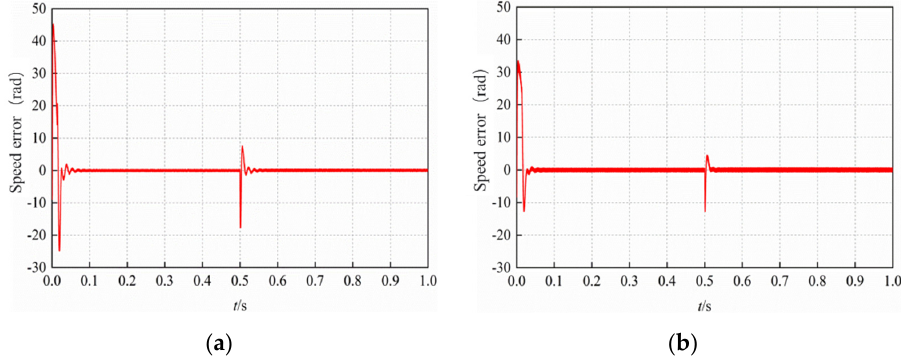
Figure 15. Simulation waveform of motor speed error under load torque mutation. ( a ) Traditional MRAS algorithm. ( b ) STSM − MRAS algorithm.